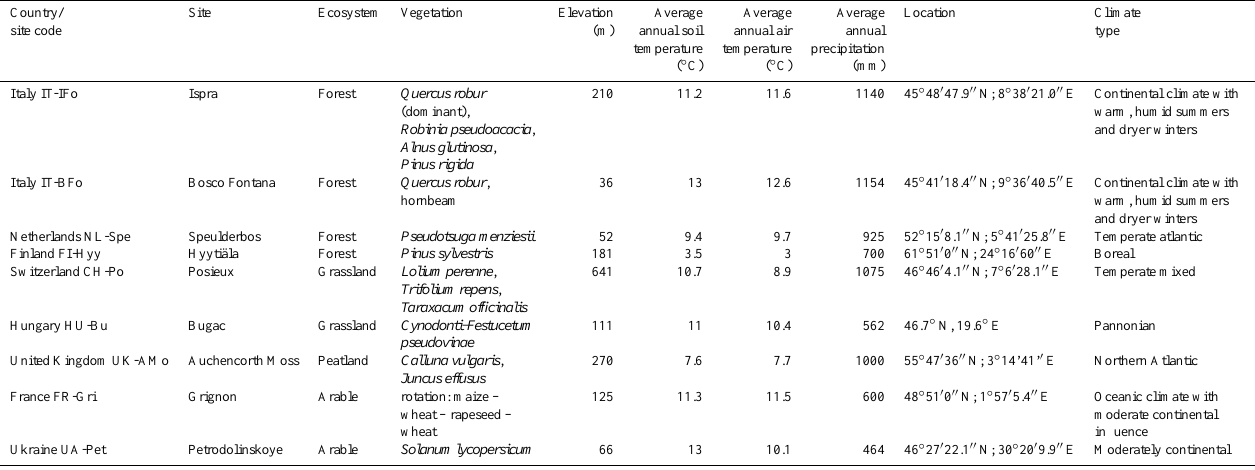
Table 1. Sampling sites with information on ecosystem, geographical location, climate type, long-term mean annual temperature and rainfall. Country/